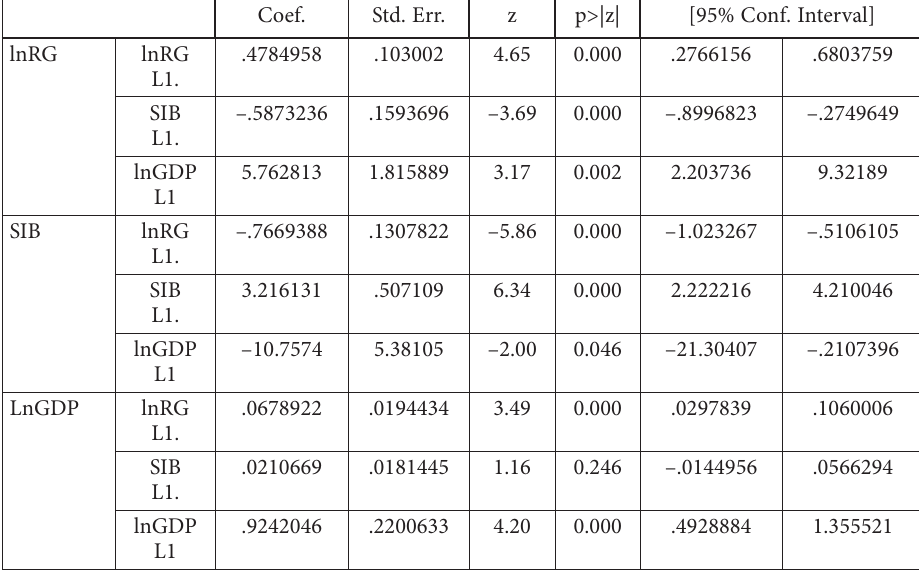
Table 7. Panel vector autoregression – GMM Estimation (source: author’s calculation using STATA programme, 2021) Coef. Std. Err. z p>|z| [95% Conf. Interval] lnRG lnRG L1.